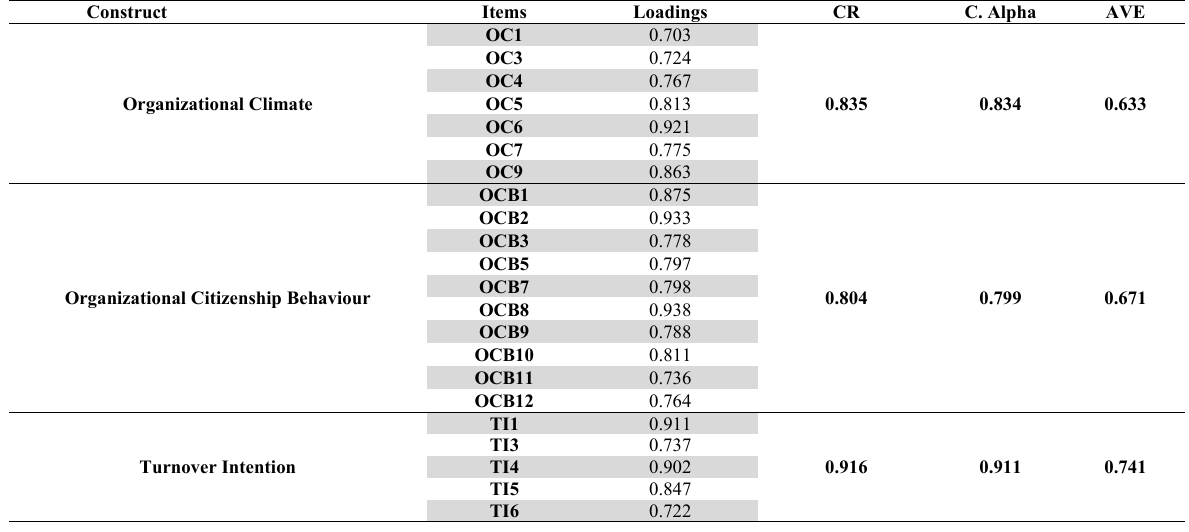
Measurement model